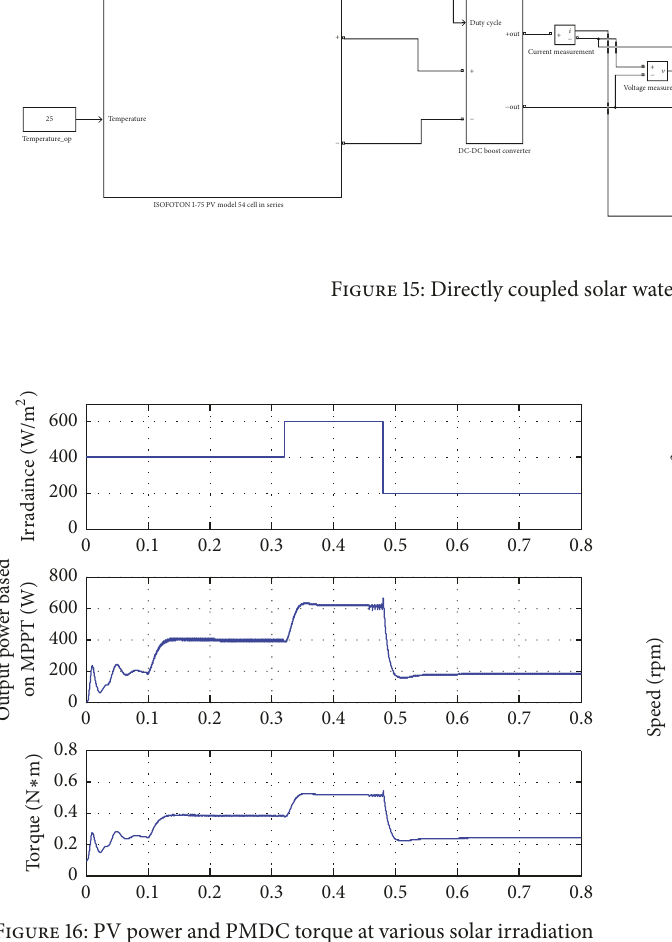
Figure 16: PV power and PMDC torque at various solar irradiation values.